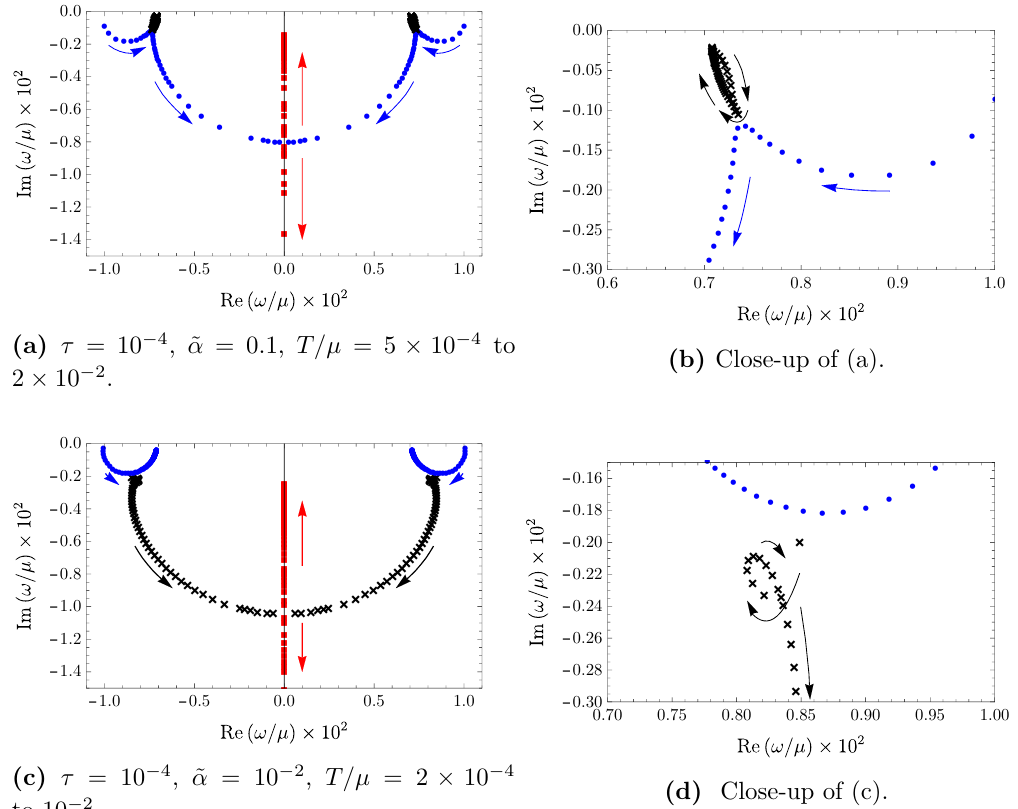
(c) (cid:28) = 10 (cid:0) 4 , ~ (cid:11) = 10 (cid:0) 2 , T=(cid:22) = 2 (cid:2) 10 (cid:0) 4 to 10 (cid:0) 2 . Figure 9. Positions of poles of G J and G tt in the complex !=(cid:22) plane with (cid:28) = 10 (cid:0) 4 for di(cid:11)erent ~ (cid:11) . We have enhanced Re ( !=(cid:22) ) and Im ( !=(cid:22) ) by 10 2 for clarity. The arrows indicate the movement of poles as T=(cid:22) increases. (a) and (b) ~ (cid:11) = 0 : 1 and 5 (cid:2) 10 (cid:0) 4 (cid:20) T=(cid:22) (cid:20) 2 (cid:2) 10 (cid:0) 2 . At T=(cid:22) = 5 (cid:2) 10 (cid:0) 4 we (cid:12)nd four poles, two HZS poles (black crosses) and two relativistic poles (blue dots). As T=(cid:22) increases the black crosses execute a loop-the-loop and eventually become hydrodynamic sound poles, while the blue dots move down, then back up, and then down and towards the imaginary axis, where they collide and split into two imaginary poles, one of which becomes the hydrodynamic charge di(cid:11)usion pole. (c) and (d) ~ (cid:11) = 10 (cid:0) 2 and 2 (cid:2) 10 (cid:0) 4 (cid:20) T=(cid:22) (cid:20) 10 (cid:0) 2 . At T=(cid:22) = 2 (cid:2) 10 (cid:0) 4 we again (cid:12)nd four poles, two HZS (black crosses) and two relativistic (blue dots). However now as T=(cid:22) increases the blue dots move down and then back up, becoming hydrodynamic sound, while the black crosses execute a loop-the-loop and then move down and towards the imaginary axis, where they collide and split into two imaginary poles, one of which becomes the hydrodynamic charge di(cid:11)usion